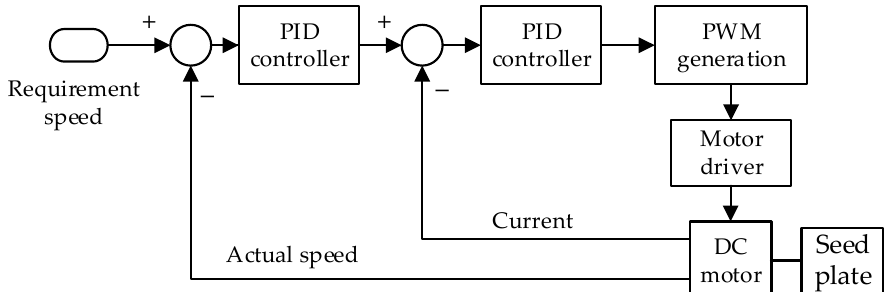
Figure 12. Control structure of the seed metering device.